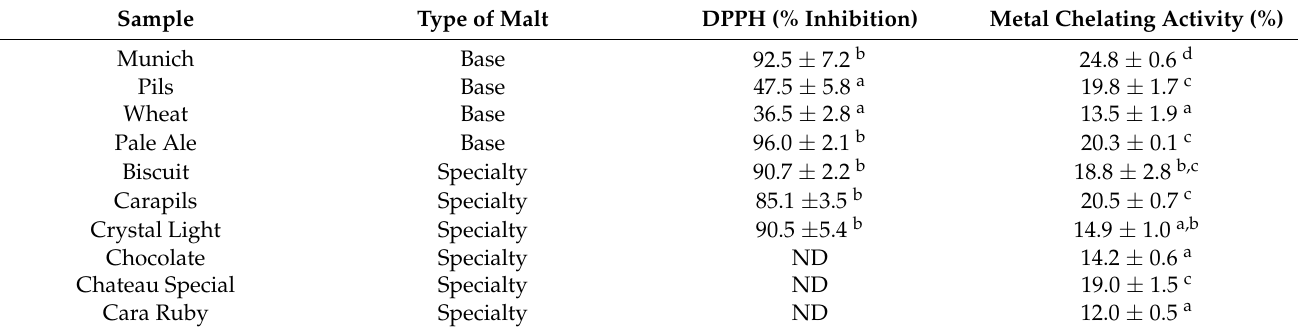
Table 4. Antioxidant Activity of Malt